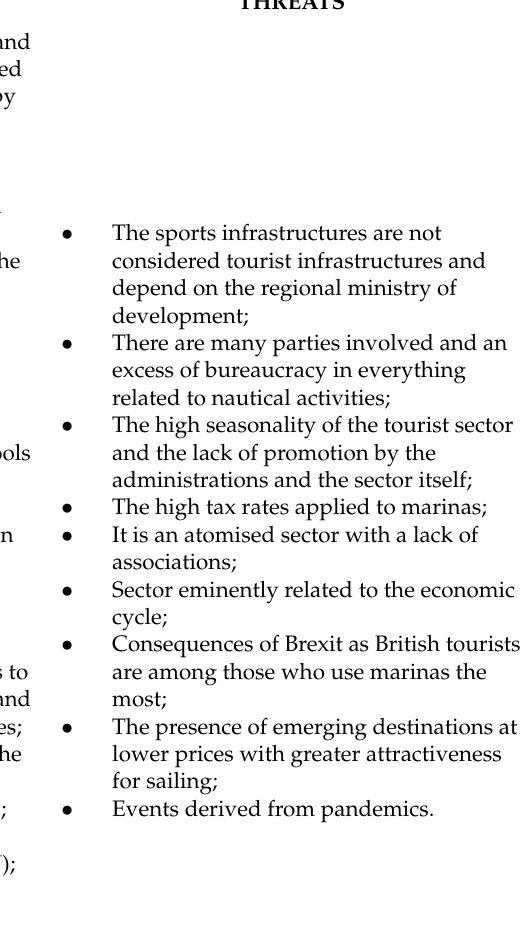
Table 4. Cont . OPPORTUNITIES